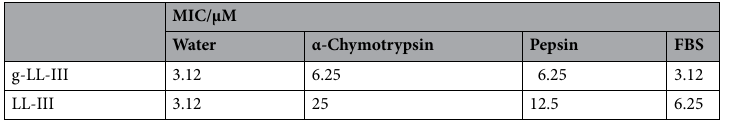
Table 3. Comparison of minimal inhibitory concentrations (MIC, in µM) of g-LL-III and LL-III against Escherichia coli ATCC 25,922 after the peptides’ treatment in water (control), with α-chymotrypsin, pepsin and 50% FBS.